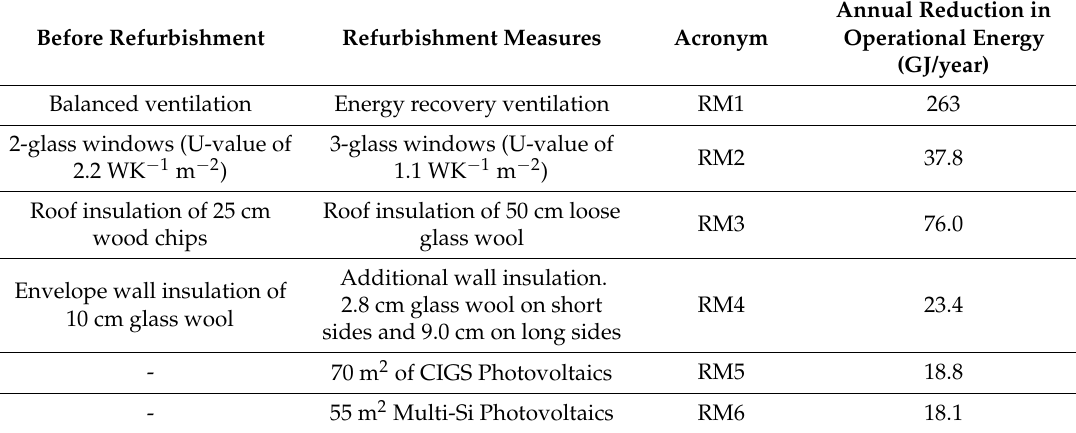
Table 1. Properties of the case building before and after